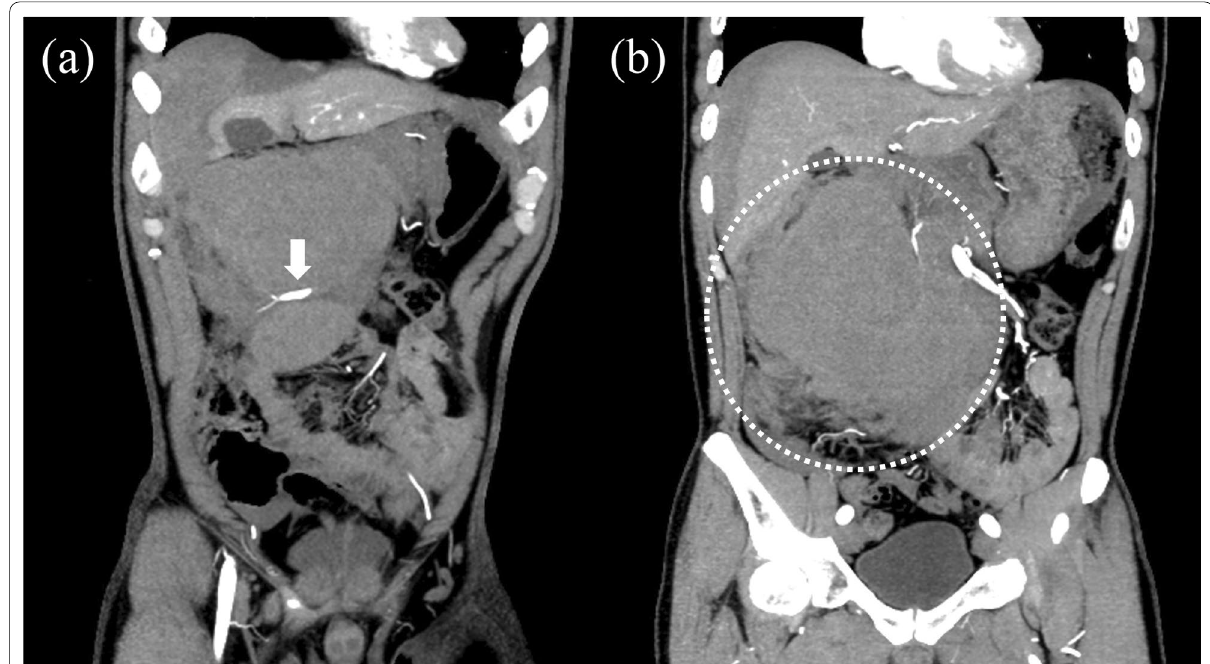
Fig. 1 The computed tomography image shows the spindle-shaped aneurysm of the right colic artery (arrow) ( a ) and a large mesenteric hematoma ( b